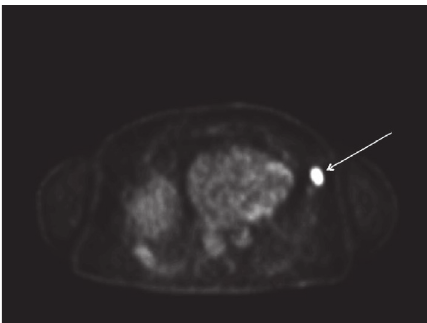
Figure 1: Computed tomography angiography of the thorax show- ing well-circumscribed, ovoid “cannonball” costophrenic mass in right lower lung lobe, consistent with appearance of metastasis.